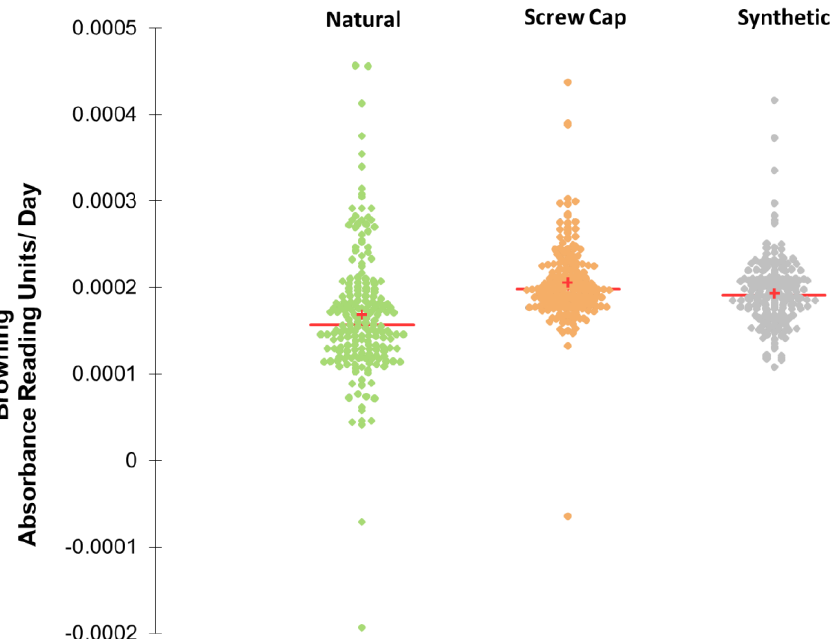
Figure 3. Scattergrams for linear browning µ -absorbance reading units per day for natural cork (green), screw cap (orange), and synthetics (grey). The red crosses correspond to the means and the central red horizontal bars represent the medians. The coefficient of variation (CV) for natural cork is 44.8%, for screw cap 20.6%, and for synthetic 21.9%.